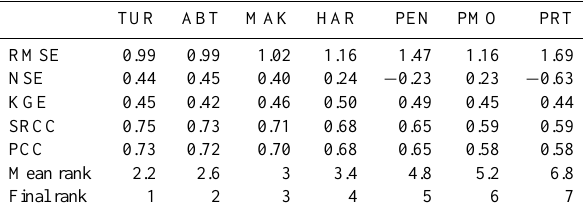
Table 5. Results of PET performance based on a ranking of the PET models according to the best overall fit for all five measures of